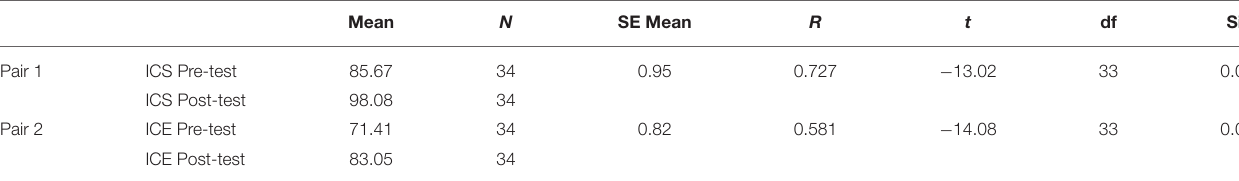
TABLE 3 | Paired-samples t -test analyses of ICS and